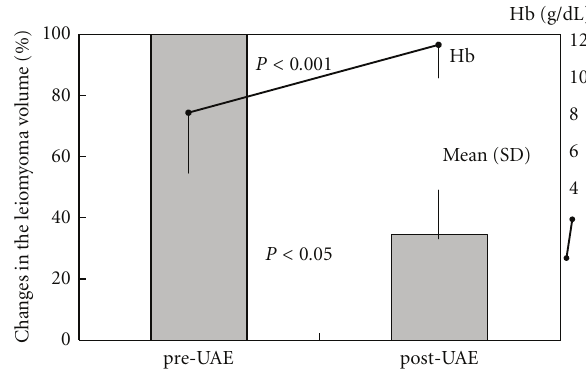
Figure 1: Changes in the leiomyoma volume ( n = 17) and Hb values ( n = 25) during course of the UAE treatment. UAE: uterine artery embolization; Hb: hemoglobin; SD: standard